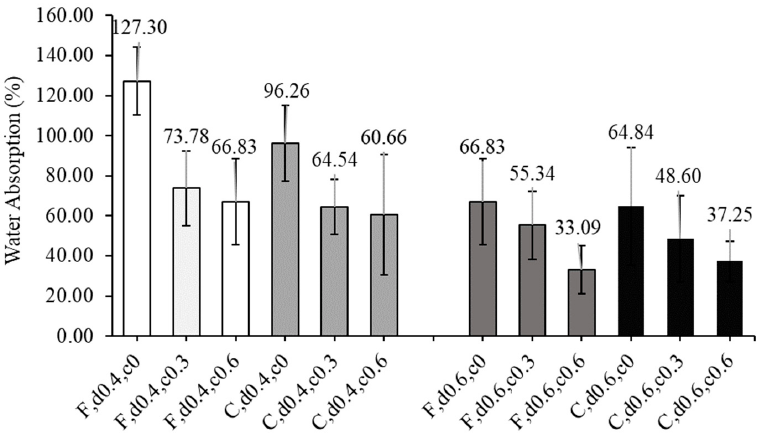
Figure 8. Water absorption (WA) 24 h values of bamboo particle board at various PU coating thickness with difference particle size and board density. Table 4. Analysis of variance (ANOVA) of multiple regression for the effect of PU coating thickness, different particle size, and board density on the thickness swelling values.